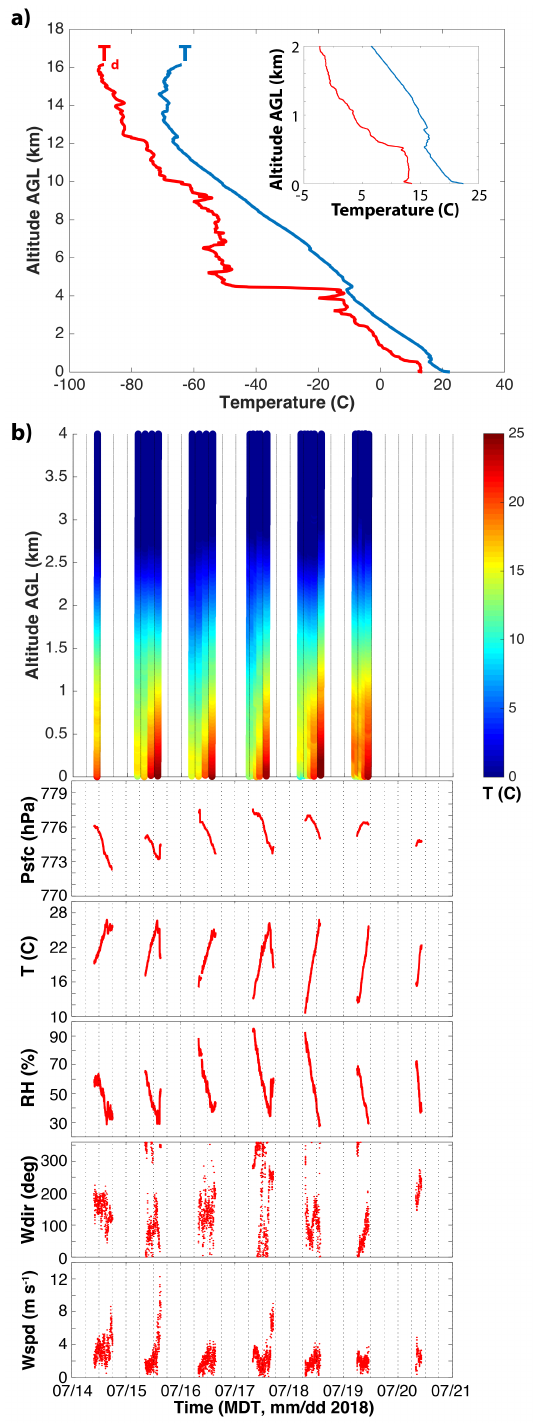
Figure 2. Radiosonde data. ( a ) Radiosonde data, including temperature ( T , blue line) and dew point temperature ( T d , red line), from 14 July (17:43 UTC launch time) and ( a )—insert focuses on the radiosonde data from surface to 2 km above ground level (AGL). ( b ) Data from radiosonde launches (top) and MURC (bottom) for each day during the week-long